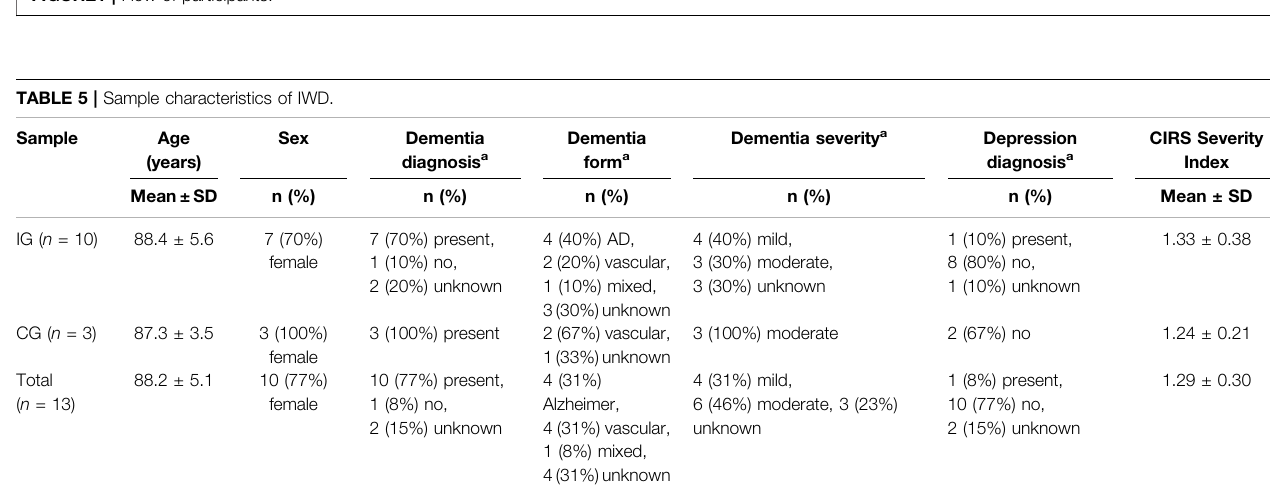
FIGURE1 | Flow of participants.